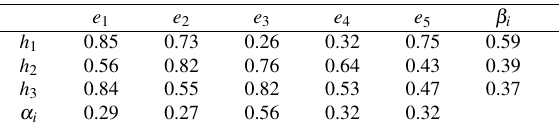
Table 6: Tabular representation of ( F , A ) with α i and β j values